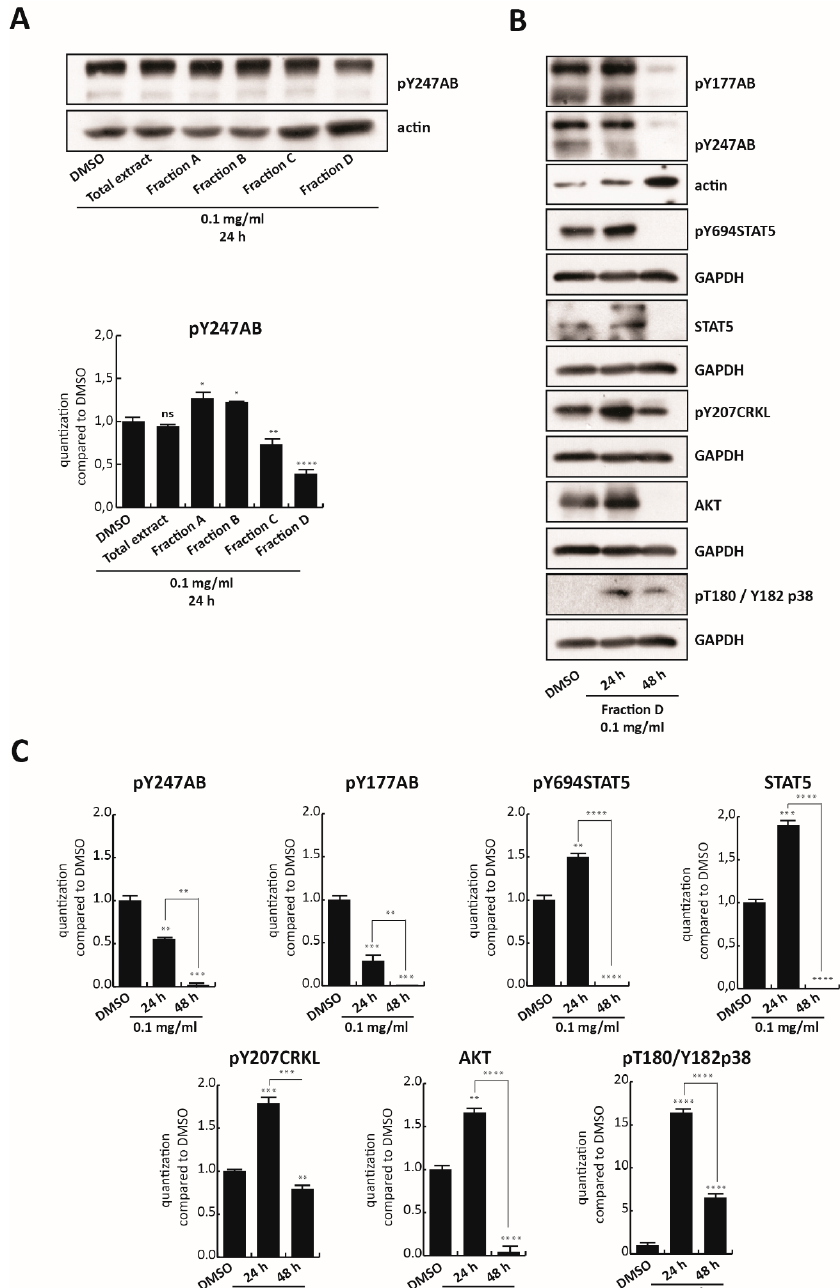
Figure 4. Fraction D inhibits BCR-ABL/STAT5. ( A , upper panel) Western blot analysis of pY247AB expression levels in K562 cells after 24 h treatment with TR total extract and all four fractions at 0.1 mg/mL. ( A , lower panel) Graphic normalization by ImageJ software. ( B ) pY247AB, pY177AB, pY694STAT5, STAT5, pY207CRKL, AKT, and pT180/Y182p38 expression levels in K562 cells treated with Fraction D at 0.1 mg/mL for 24 and 48 h. ( C ) Normalization of protein level expression by the ImageJ software. Values are mean ± SD of biological duplicates. **** p -value ≤ 0.0001, *** p -value ≤ 0.001, ** p -value ≤ 0.01, * p -value ≤ 0.05, ns p -value > 0.05 vs. control